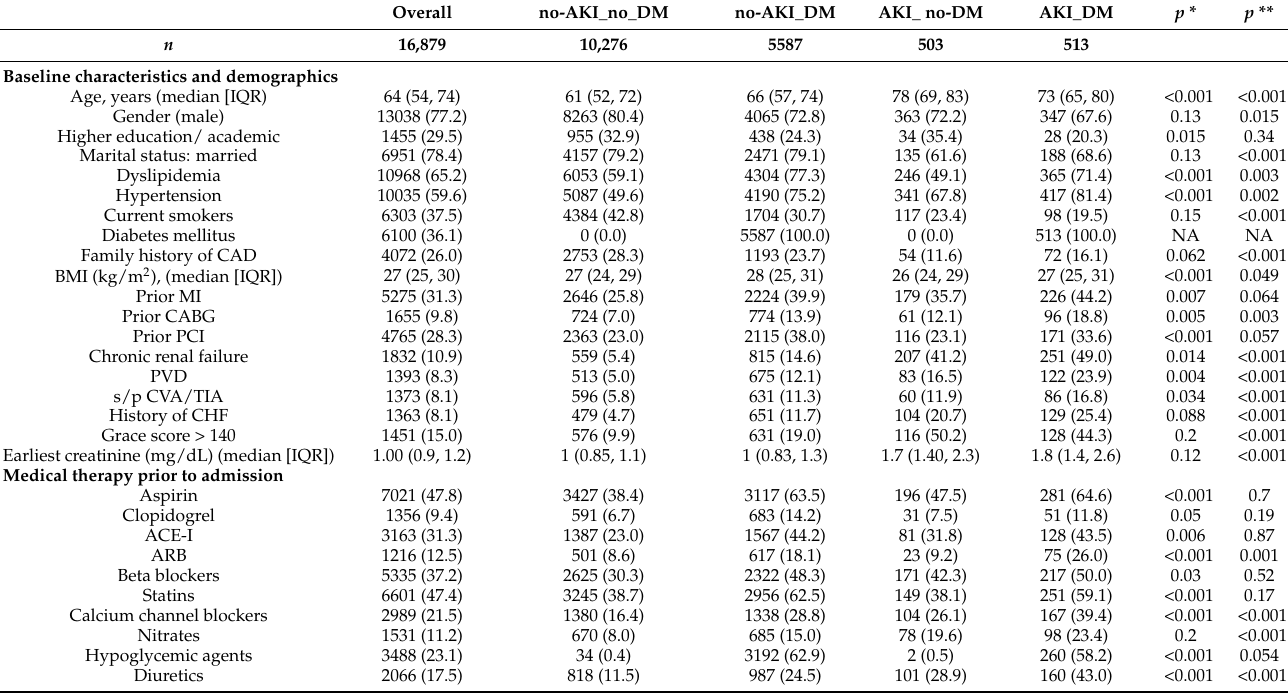
Table 1. Baseline characteristics by DM status and